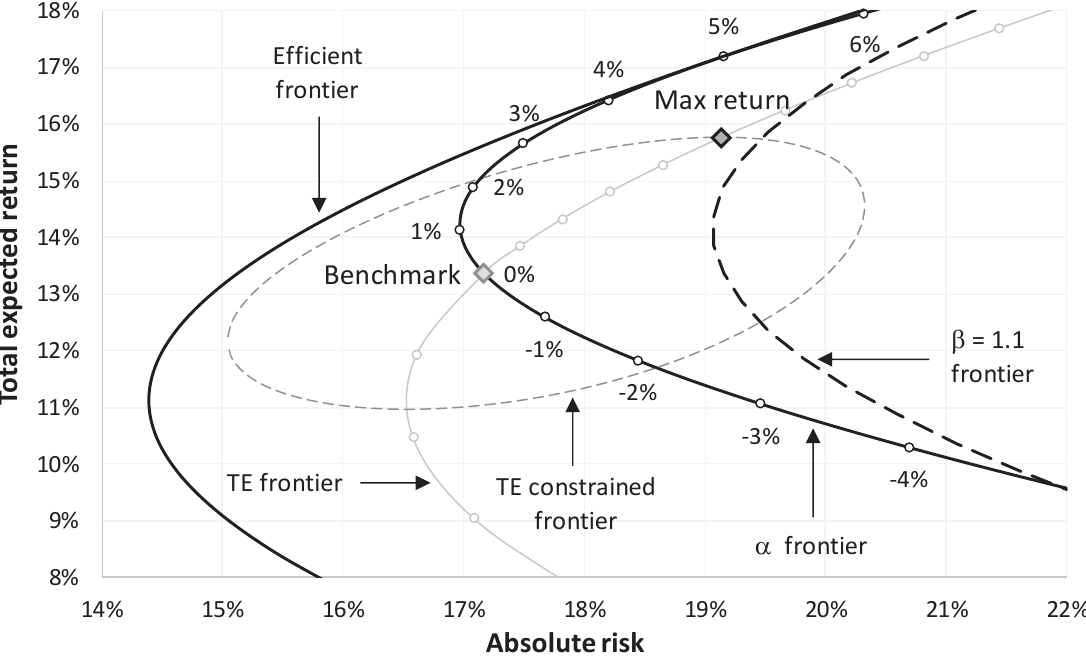
Figure 4. The - TE α frontier for various levels of . α Other frontiers are shown for comparison. Levels of α are indicated on the graph.